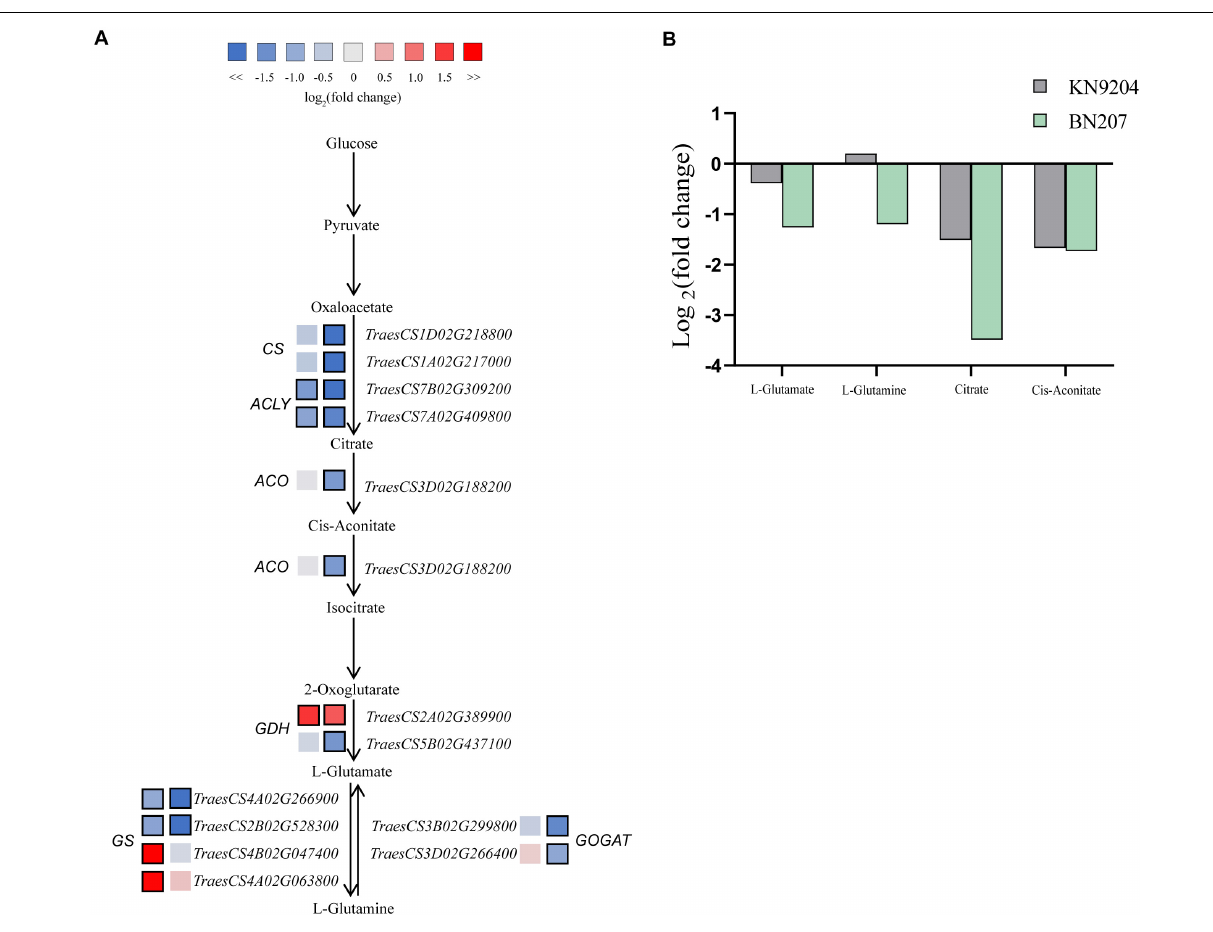
FIGURE 3 | Changes in the gene expression levels and metabolite contents associated with the glutamate biosynthesis pathway of BN207 and KN9204 after the low-K treatment. (A) Glutamate biosynthesis pathway. Log 2 fold-changes in DEG expression levels in KN9204 (left box) and BN207 (right box). Blue and red boxes respectively indicate the down- and up-regulated expression of the DEGs under low-K stress conditions. Bold margins indicate significant differences ( p < 0.05) between treatments. (B) Changes to the metabolites in the glutamate biosynthesis